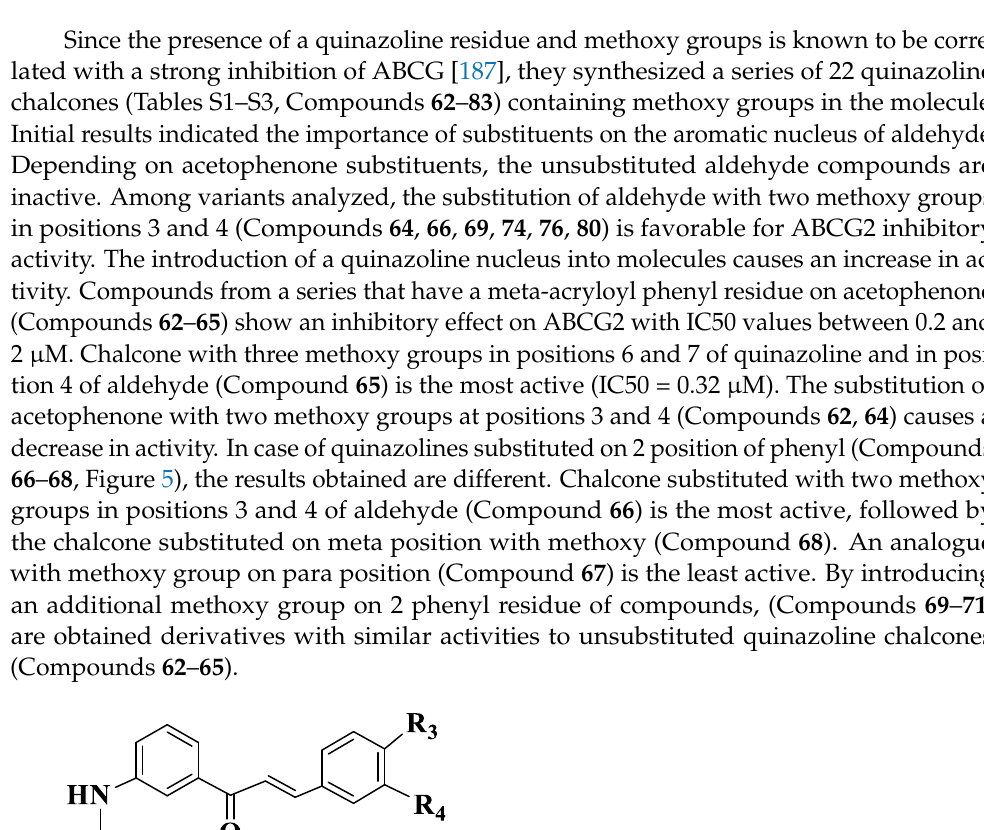
Figure 4. General structure of naphthochalcones (compounds 58 – 61 ).